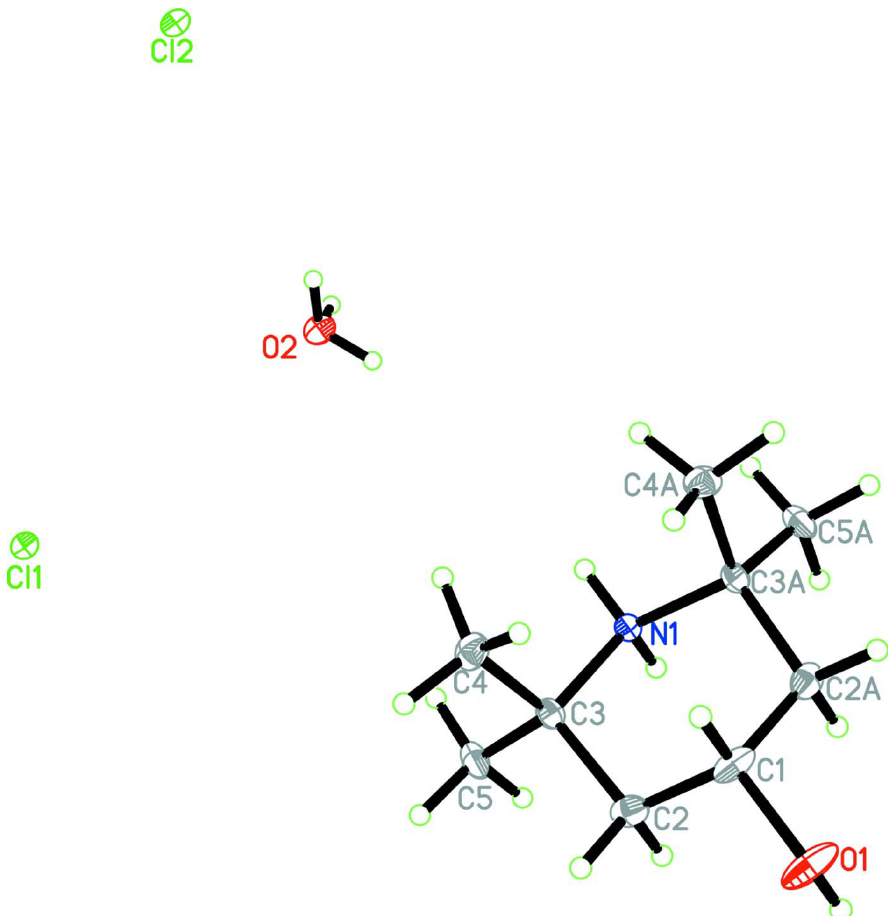
Figure 1 Crystal structure of the title compound with labeling and displacement ellipsoids drawn at the 30% probability level. H atoms are shown as small spheres of arbitrary radii. Symmetry codes: A = x , y ,0.5 - z